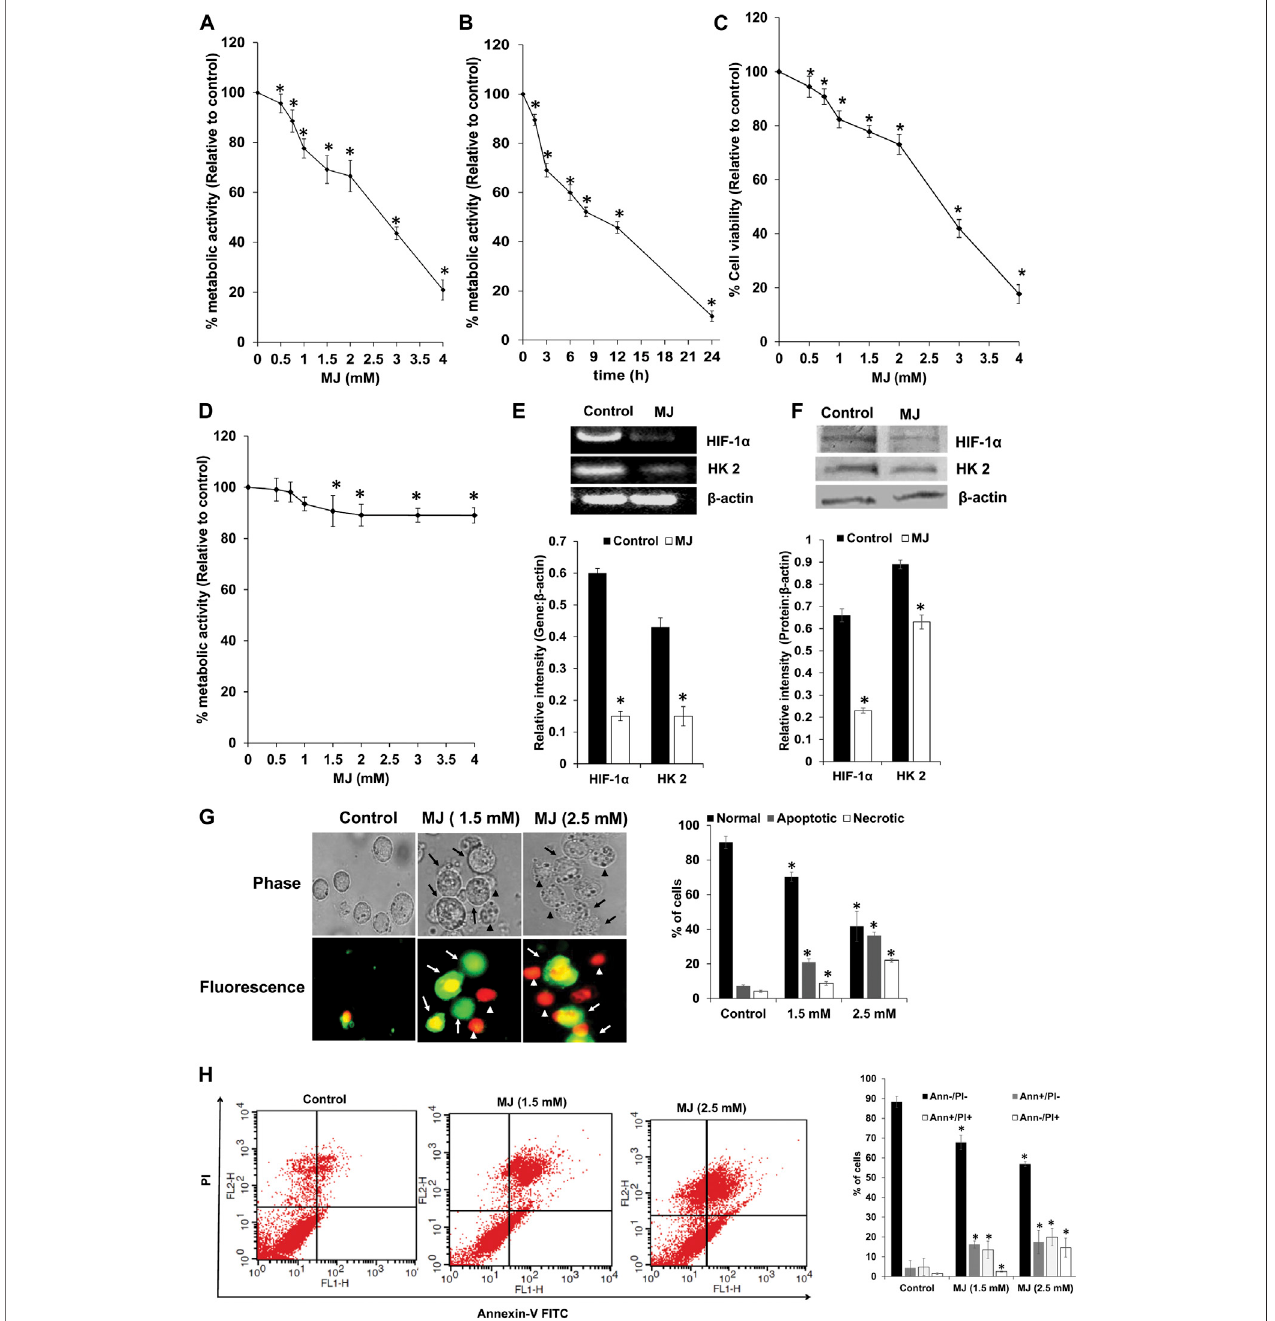
FIGURE2| EffectofMJontumorcellmetabolicactivity,expressionofmetabolicmolecules,tumorcellsurvival,apoptosis,andcytokinerepertoire.Tumorcells(1 × 10 5 cells/ml)wereincubatedinmediumaloneorcontainingtheindicatedconcentrationsofMJ (A) for18 horinmediumwith2.5 mMMJfortheindicatedtimedurations followed by estimation of metabolic activity (A,B) , and cell survival (C) as described in the materials and methods. Thymocytes (1 × 10 5 cells/ml) were incubated in medium with or without the indicated concentration of MJ for 18 h, followed by estimation ofmetabolic activity (D) . Cell lysates of control and MJ-treated (2.5 mM) tumor cells(1 × 10 5 cells/ml)were examinedforgene andprotein expression oftheindicatedmetabolic molecules byRT-PCR andwesternblotting,respectively. Bands shown arefrom arepresentative experiment outofthree independent experiments withasimilar pattern.Theaccompanying bar diagrams are thedensitometry analysis of the bands (E,F) . Tumor cells (1 × 10 5 cells/ml) were incubated in medium alone or containing the indicated concentration of MJ for 18 h followed by estimation of cell deathby fl uorescencemicroscopy (G) and fl owcytometry (H) ,asdescribedinthematerialsandmethods.Arrowsandarrowheadsindicateapoptoticandnecroticcells, respectively in the microscopic images. Flow cytometric and microscopic fl uorescence images are from a representative experiment out of three independent experiments with a similar pattern. Values shown are bar diagrams are mean ± SD of three independent experiments. * p < 0.05 vs. respective control.